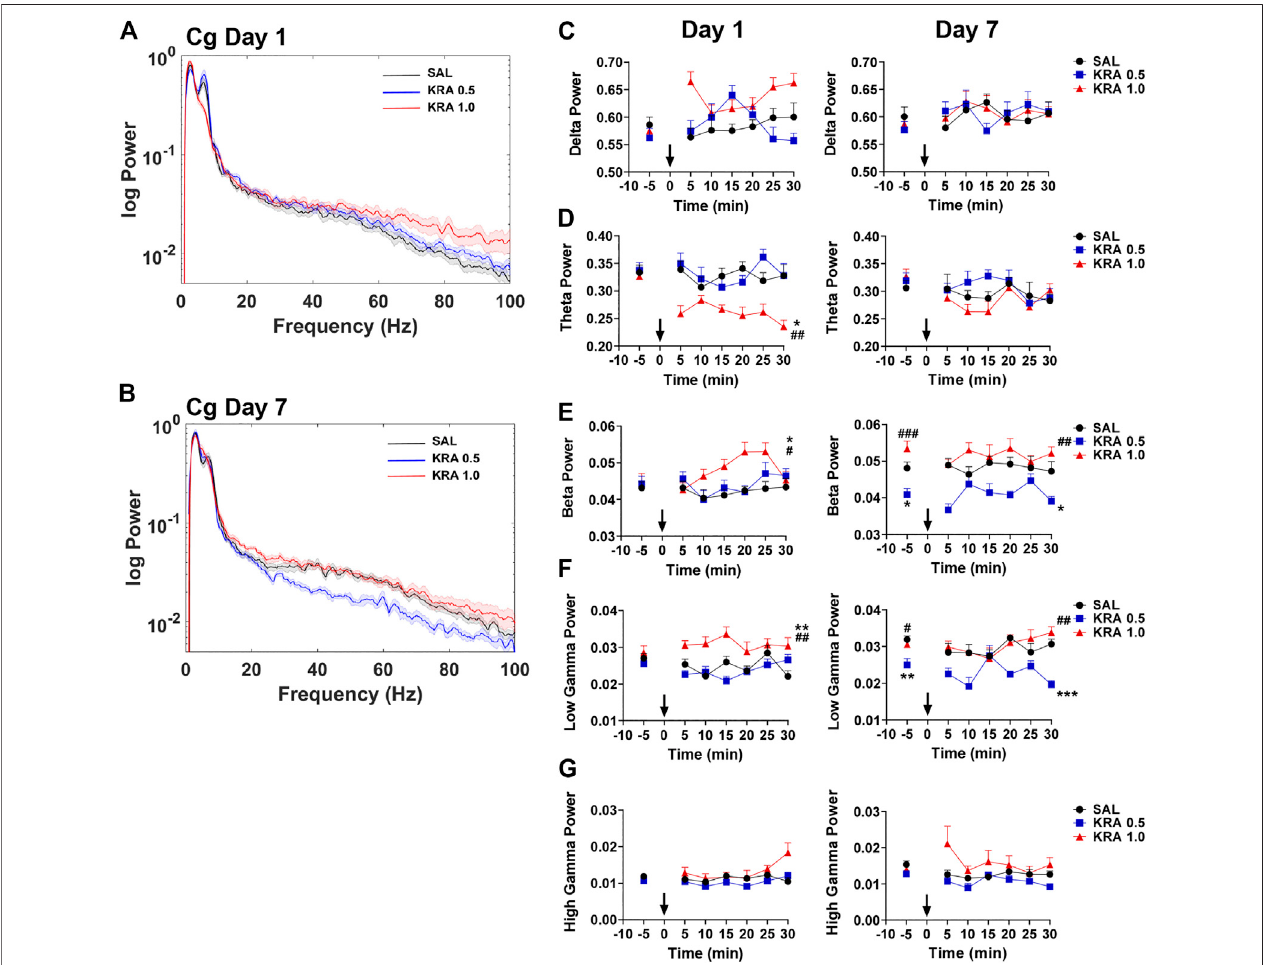
FIGURE 4 | Time course of dose-dependent effects of kratom on Cg spectral power. (A,B) Representative power spectra showing dose-dependent (0, 0.5, 1.0 mg/kg)effectsofkratom30 minpost-injectiononday1andday7. (C) Nokratom-inducedchangesindeltapowerwereevidentonday1orday7intheCg. (D) High dose kratom supressed theta power in on day 1 with no changes evident on day 7. (E) High dose kratom increased beta power on day 1. On day 7, reduced baseline betapowerwasobservedinresponsetolowdosekratom,andthischangepersisted followingthe fi nalinjection. (F) Highdosekratomelevated lowgammapower on day 1. Low dose kratom decreased baseline low gamma power on day 7 and this effect was maintained after the last injection. (G) No effects of kratom treatment were observed in the high gamma frequency band. N (cid:2) 7 – 10 rats per group, with 2 electrodes/rat. Curves are represented as means with jackknife estimates of sem depicted bythe shaded areas. Bars represent mean ± sem.* p < 0.05,** p < 0.01, *** p < 0.001 compared tosaline control rats. ## p < 0.01, ### p < 0.01compared tolow dose kratom treated rats.